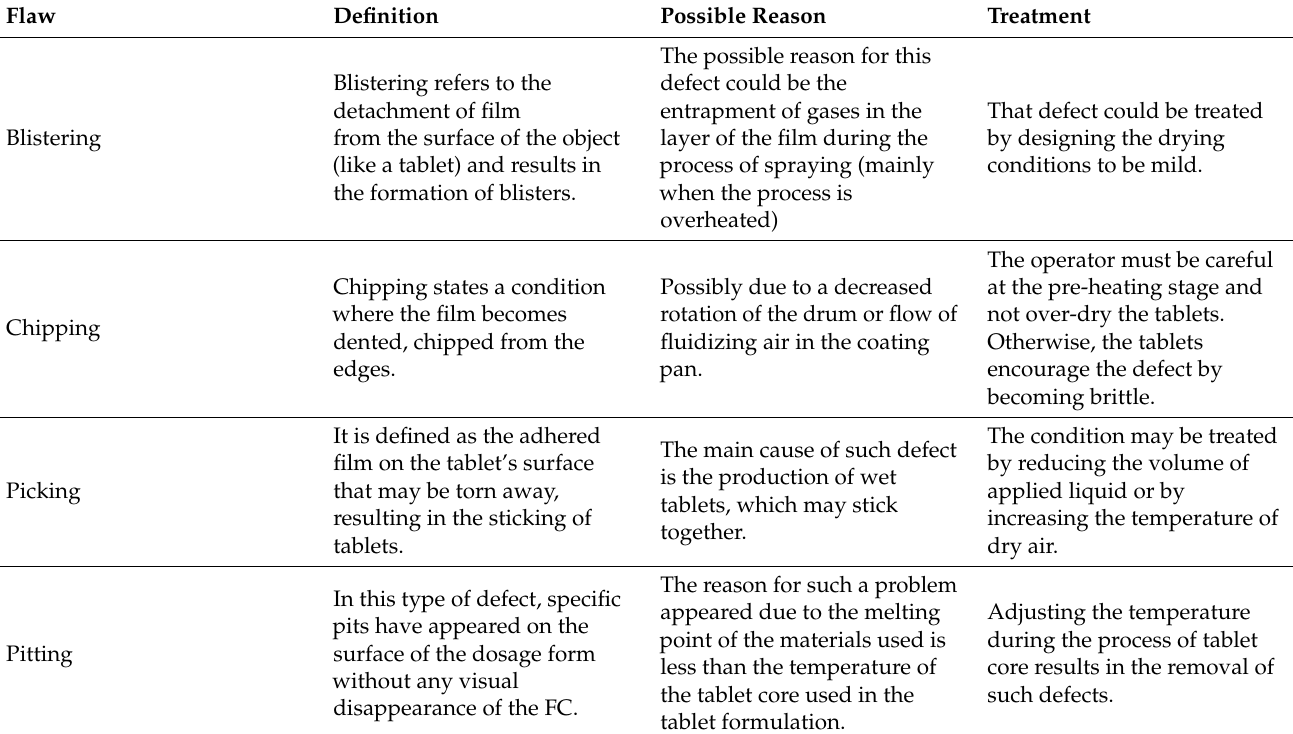
Table 2. Representing drawbacks of